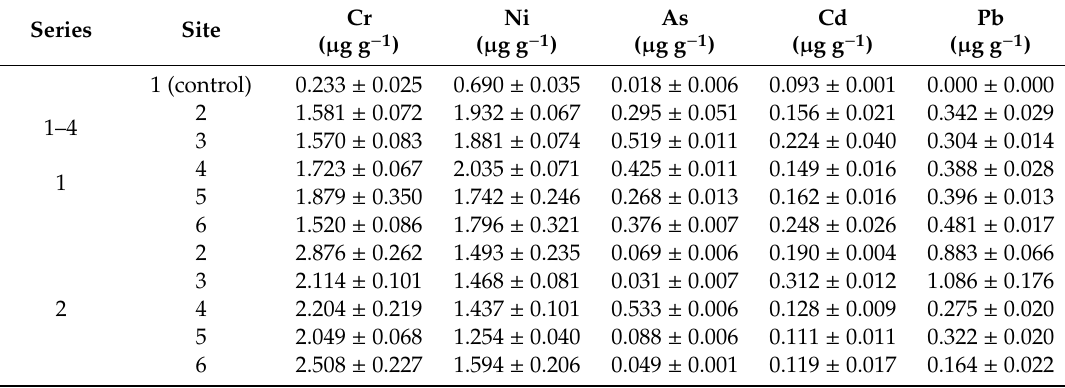
Table 2. Trace elements concentrations (means ± SD, n = 5) in L. multiflorum leaves measured after four exposure at exposure and control